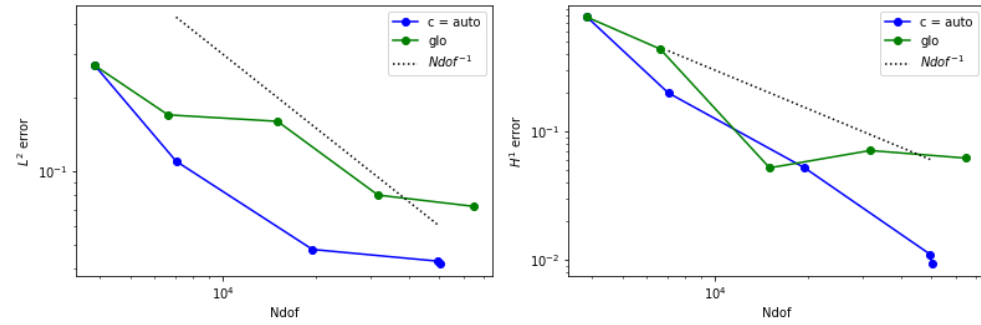
Figure 14. Error behavior for example 2 when η N is adopted. ( Left ) The estimated L 2 norm of the error is displayed. ( Right ) The estimated H 1 seminorm is shown.